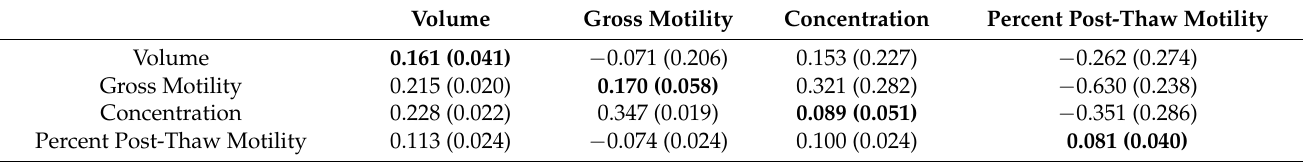
Table 3. Genetic parameters of semen traits. Heritabilities of the transformed ejaculate quality and quantity traits are presented in bold face on the diagonal of the table. Genetic and phenotypic correlations between different combination of traits are presented above and below the diagonal respectively. Standard errors are presented in